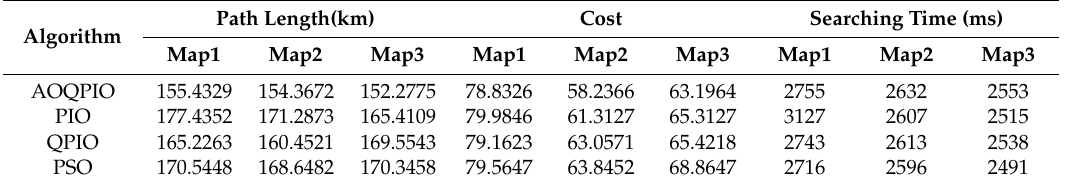
Table 2. The statistical results of path length, cost, and running time of the algorithms in the three maps.